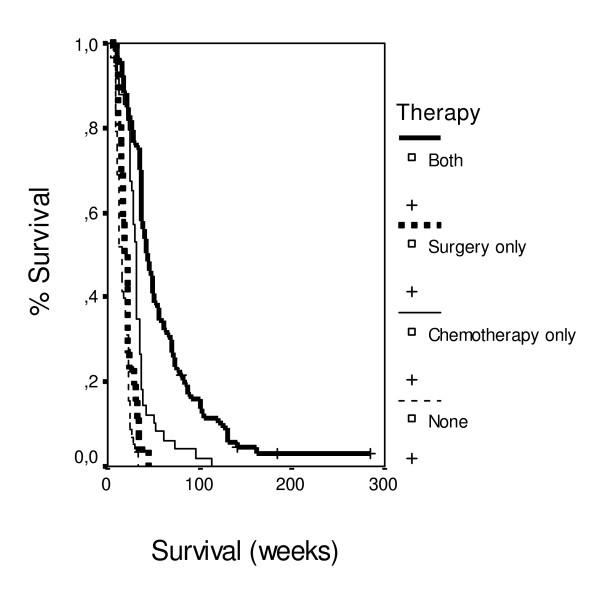
Survival data according to therapy.